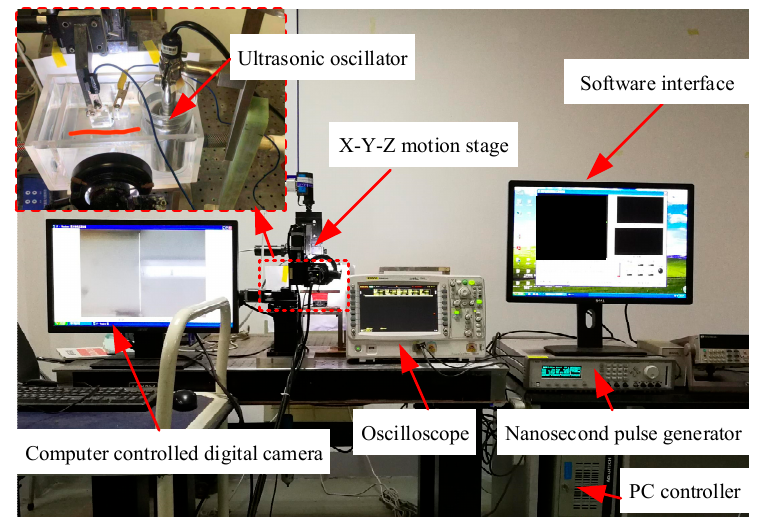
Figure 4. Experimental system for WECMM of rectangular mandrel.